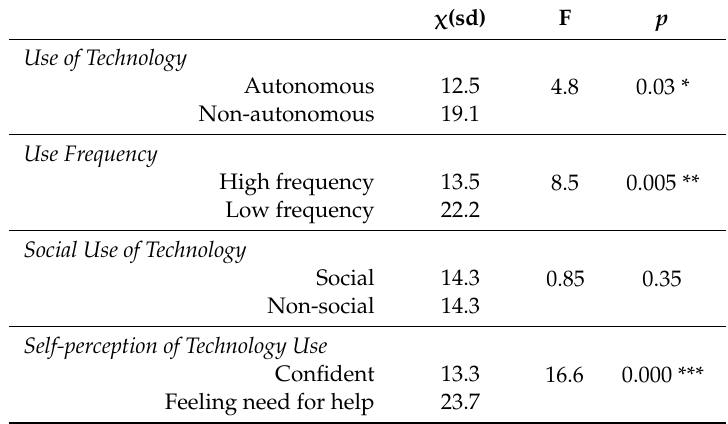
Table 2. One-way analysis of variance comparing Short Computer Anxiety Scale and technology use